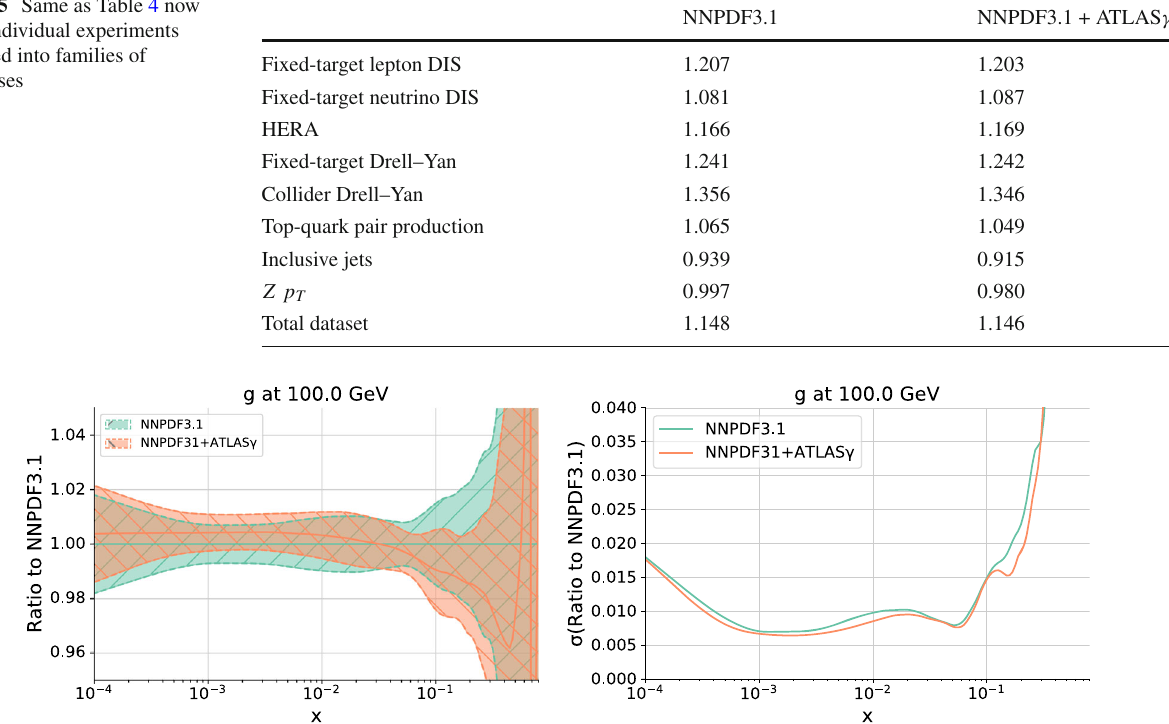
Fig. 6 Left: comparison of the gluon PDF at Q = 100 GeV between the NNPDF3.1 and NNPDF3.1 + ATLAS γ fits, normalized to the central value of the former. Right: the corresponding relative one-sigma PDF uncertainties in each case